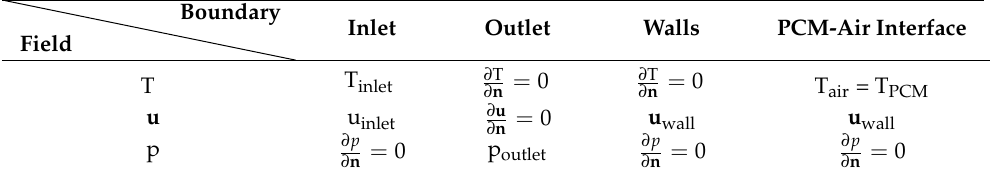
Table 4. Boundary conditions for the PCM–air heat exchanger